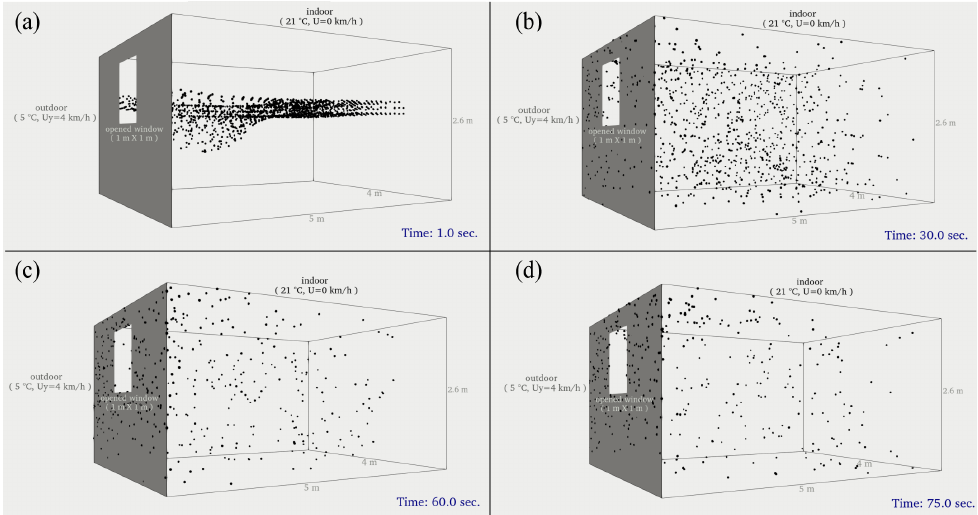
Figure 7. Local dispersion of aerosol particles indoor-outdoor. Case: Natural ventilation due to a low wind speed outdoors U y = 4 km/h and a lower outdoor temperature, walls-particles-interaction: unstick . ( a ) t = 1 s showing the initially stratified layer of 3108 aerosol particles (0.15 µ m in diameter) placed between z = 1.5 m and z = 1.7 m; ( b ) t = 30 s; ( c ) t = 60 s; ( d ) t = 75 s. See the Supplementary Materials Video